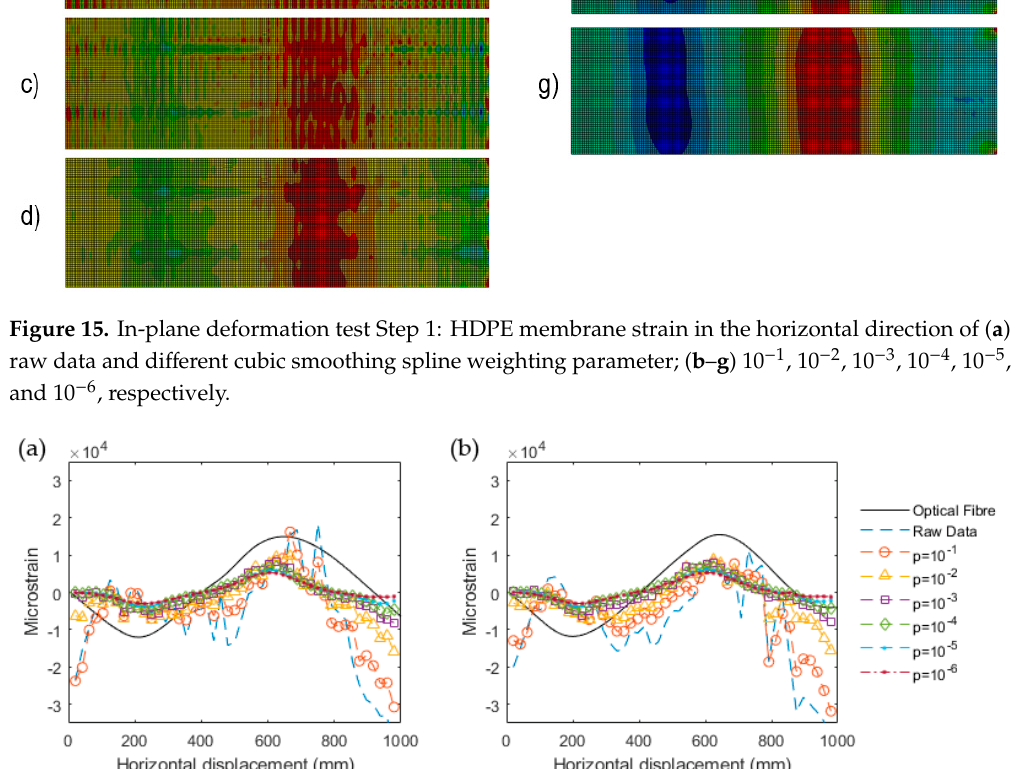
Figure 15. In-plane deformation test Step 1: HDPE membrane strain in the horizontal direction of ( a ) raw data and different cubic smoothing spline weighting parameter; ( b – g ) 10 (cid:2879)(cid:2869) , 10 (cid:2879)(cid:2870) , 10 (cid:2879)(cid:2871) , 10 (cid:2879)(cid:2872) , 10 (cid:2879)(cid:2873) , and 10 (cid:2879)(cid:2874) , respectively.